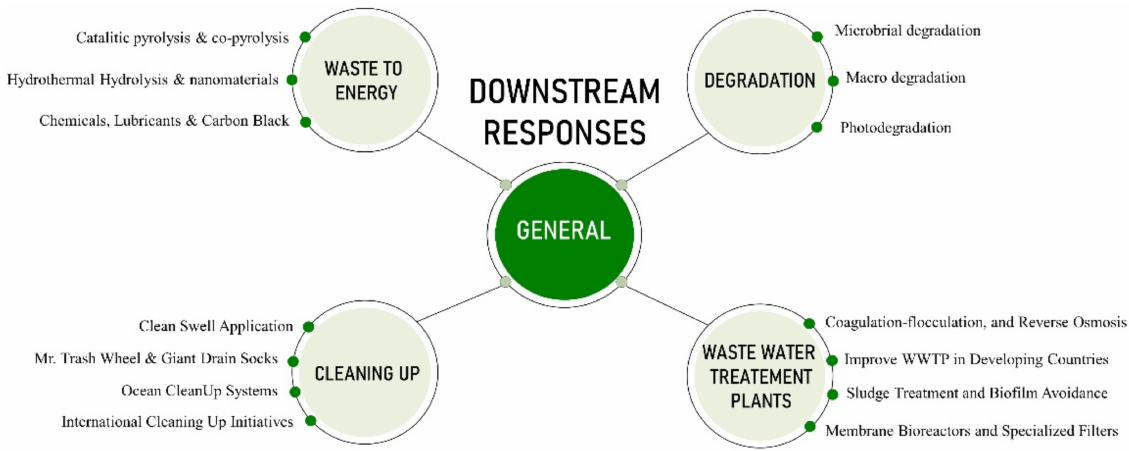
Figure 3. Downstream responses to mitigate microplastic